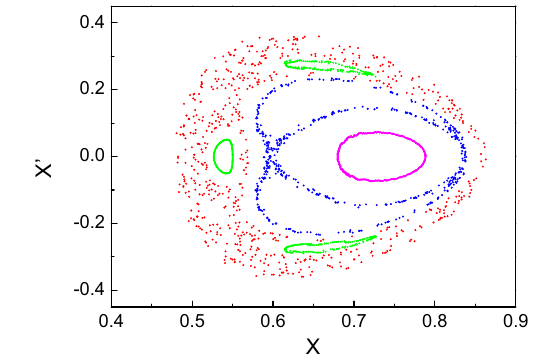
Fig. 1 Poincaré surface sections of four orbits in the Newtonian case: Orbit 1 (green), Orbit 2 (red), Orbit 3 (blue), and Orbit 4